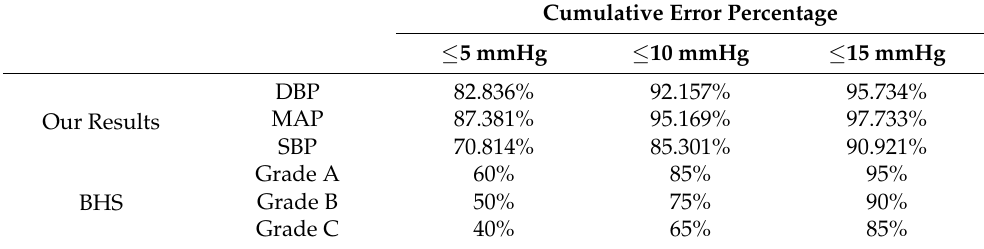
Table 2. Evaluation of BHS Standard. Here, we present the criteria used in grading the rank of predictions using the BHS Standard. We also demonstrate how our results compare with the BHS Standard.